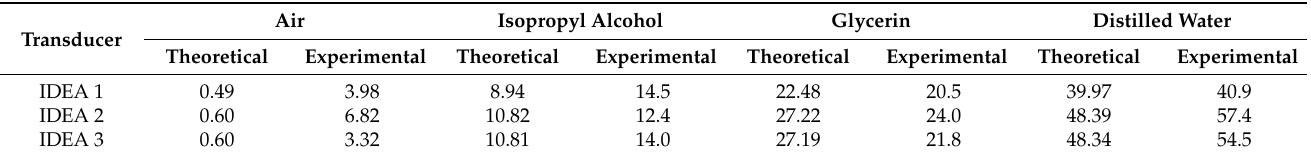
Table 3. Theoretical and experimental capacitance,